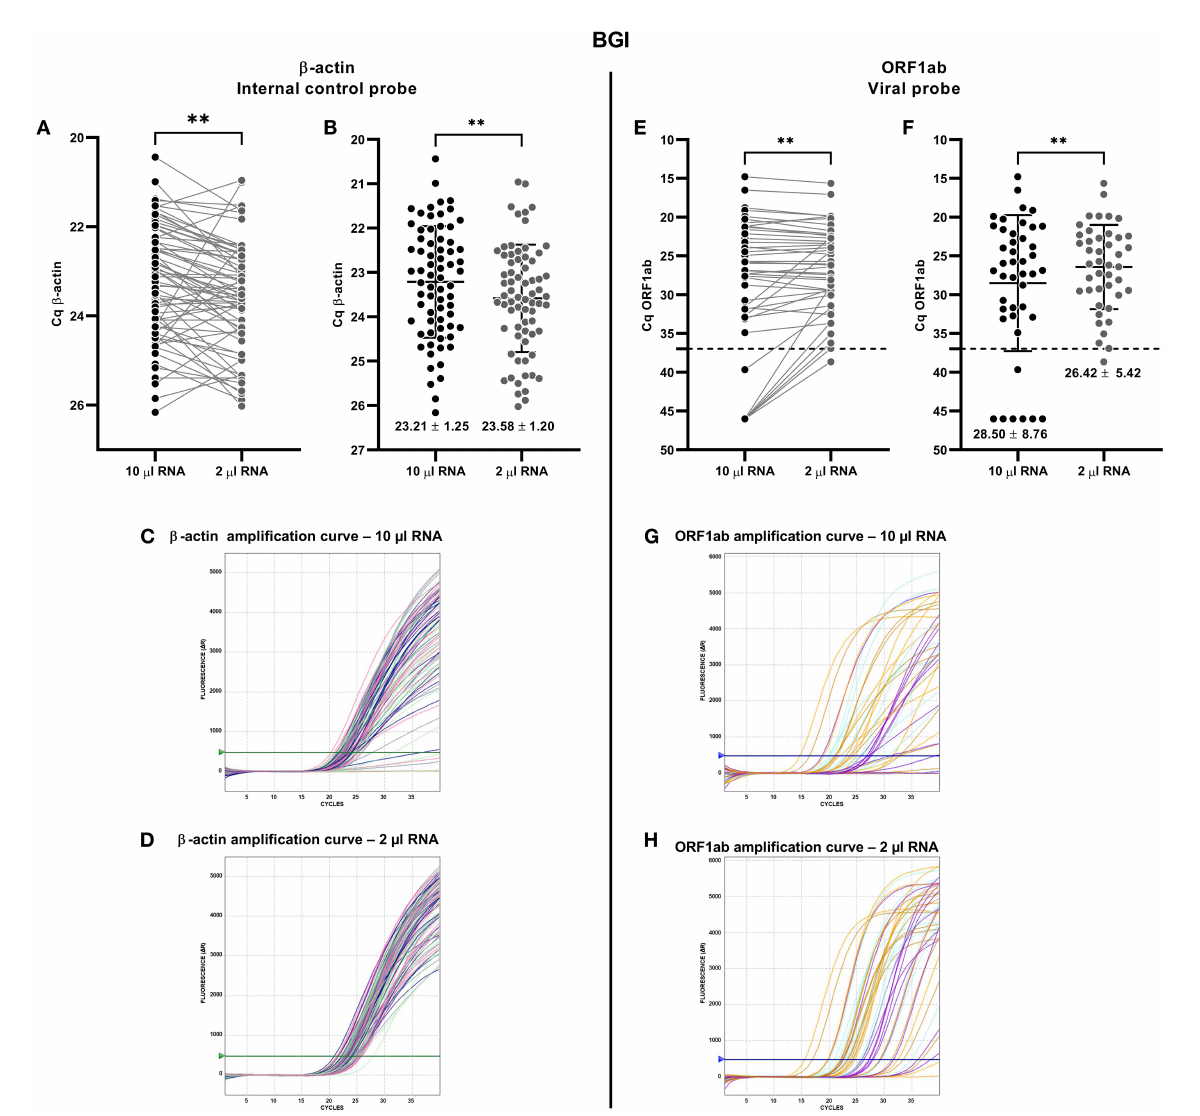
FIGURE2 Comparative analysis for detecting SARS-CoV-2 from nasopharyngeal swab (NPS) samples using β -actin and ORF1ab gene from BGI RT-qPCR kit. The comparison was made from the same NPS sample loading the recommended volume of extracted RNA (10 µ l of total RNA, recommended by the manufacturer; black spots) and 2 µ l of total RNA (gray spots). Each spot is an analyzed sample for each volume condition (10 µ l; 2 µ l). For graphs (A,E) , the line connecting the points shows the paired results obtained from the same sample analyzed by loading the two different volumes. Cq = 46 denotes no amplification (No Cq). (A) Paired quantification cycle (Cq) analysis for the β -actin probe of each sample assessed. (B) Cq means value (mean ± SD) for the β -actin probe amplification. β -actin probe amplification curves loading (C) 10 µ l and (D) 2 µ l of total RNA. (E) Paired Cq analysis for ORF1ab probe of each sample assessed. (F) Cq means value (mean ± SD) for the ORF1ab probe amplification. The broken line indicates the Cq cut-off value (Cq ≤ 37) recommended by the manufacturer. ORF1ab amplification curves loading (G) 10 µ l and (H) 2 µ l of total RNA. For statistical analysis, paired two-sided Student T -test was applied ( n = 70 NPS blind selected samples, 43 positives for SARS-CoV-2). ** p <